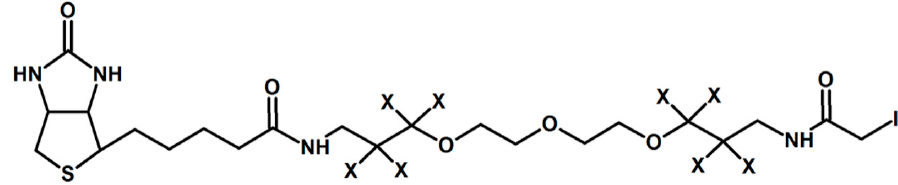
Figure 2. Isotope Coded Affinity Tag proposed by Gygi et al. [21]. X depicts H or D atoms in the molecule.